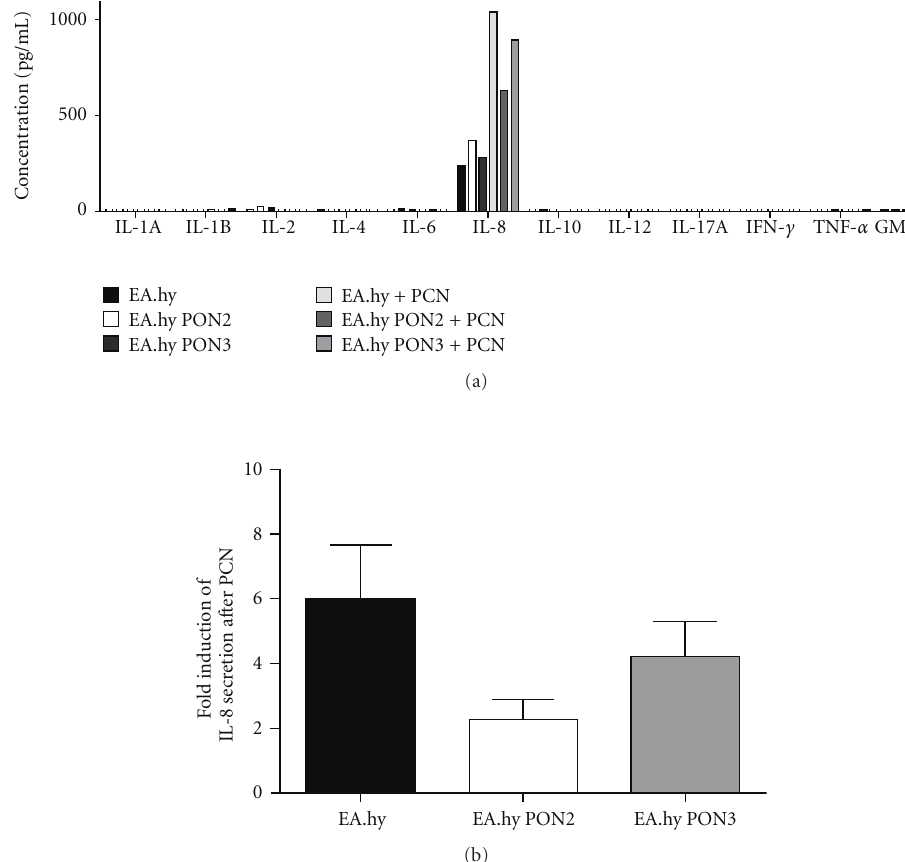
Figure 3: PCN induces IL-8 secretion, which can be lowered by PON2 or PON3 overexpression. (a) Na¨ıve, PON2-GFP or PON3-GFP overexpressing EA.hy 926 cells were treated with PCN (10 μ M, 16 h). Cell supernatants were analyzed for the secretion of the listed cytokines and chemokines by ELISA. (b) Quantitative evaluation of results from panel (a) Fold induction of IL-8 release was calculated between untreated and PCN-treated